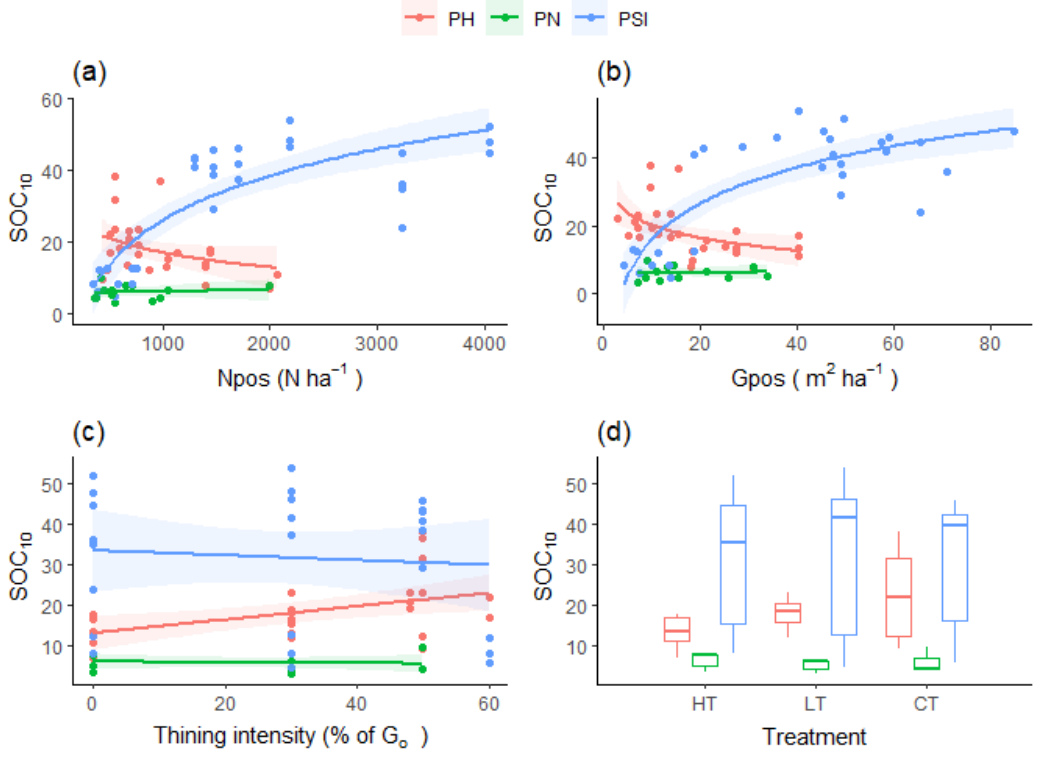
Figure 4. Soil Organic Carbon (SOC 10, 0–10 cm) relationships with dasometric variables after treat- ments ( a , b ) (Npos=density tree ha −1 , Gpos=basal area, m 2 ha −1 ), thinning intensity (% of basal area removed) c) and treatment (CT = unthinned, LT = light thinning, HT = heavy thinning) ( d ). PH= Pinus halepensis ; PN= Pinus nigra ; PSI= Pinus sylvestris . Smoothed areas around regression lines show Standard Error interval. ( a , b ) shows regression of SOC 10 for log 2 (Npos) and log 2 (Gpos) respectively. ( d ) shows linear regression of SOC 10 for thinning intensity.